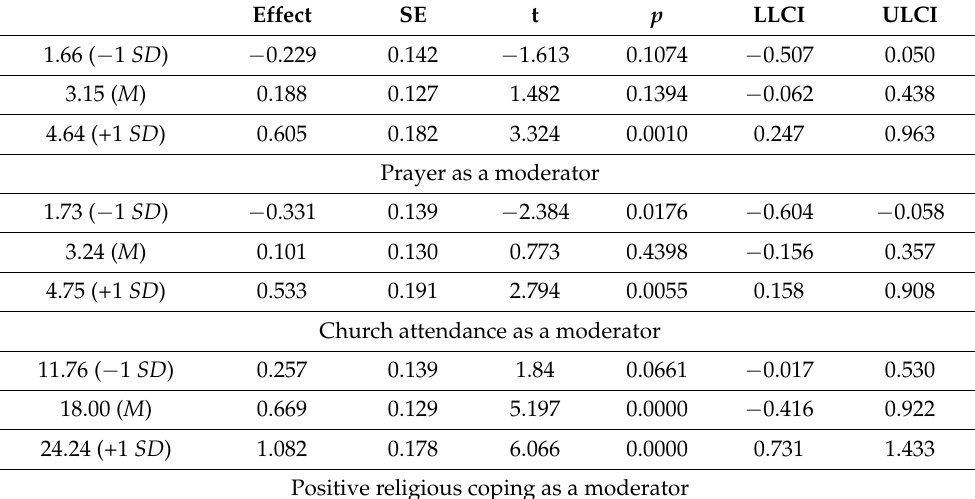
Table 4. Conditional effects of meaning in life at values of moderators.